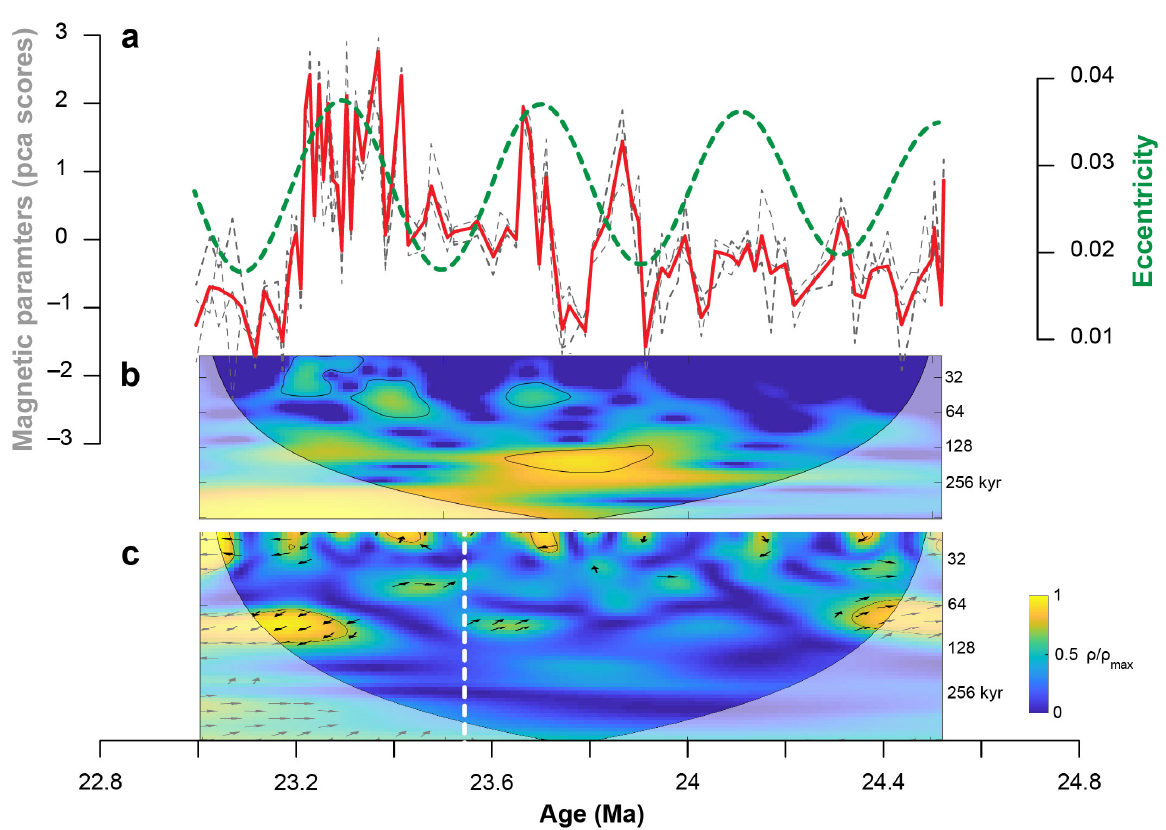
Table 1. Results of a principal component analysis of magnetic proxies.